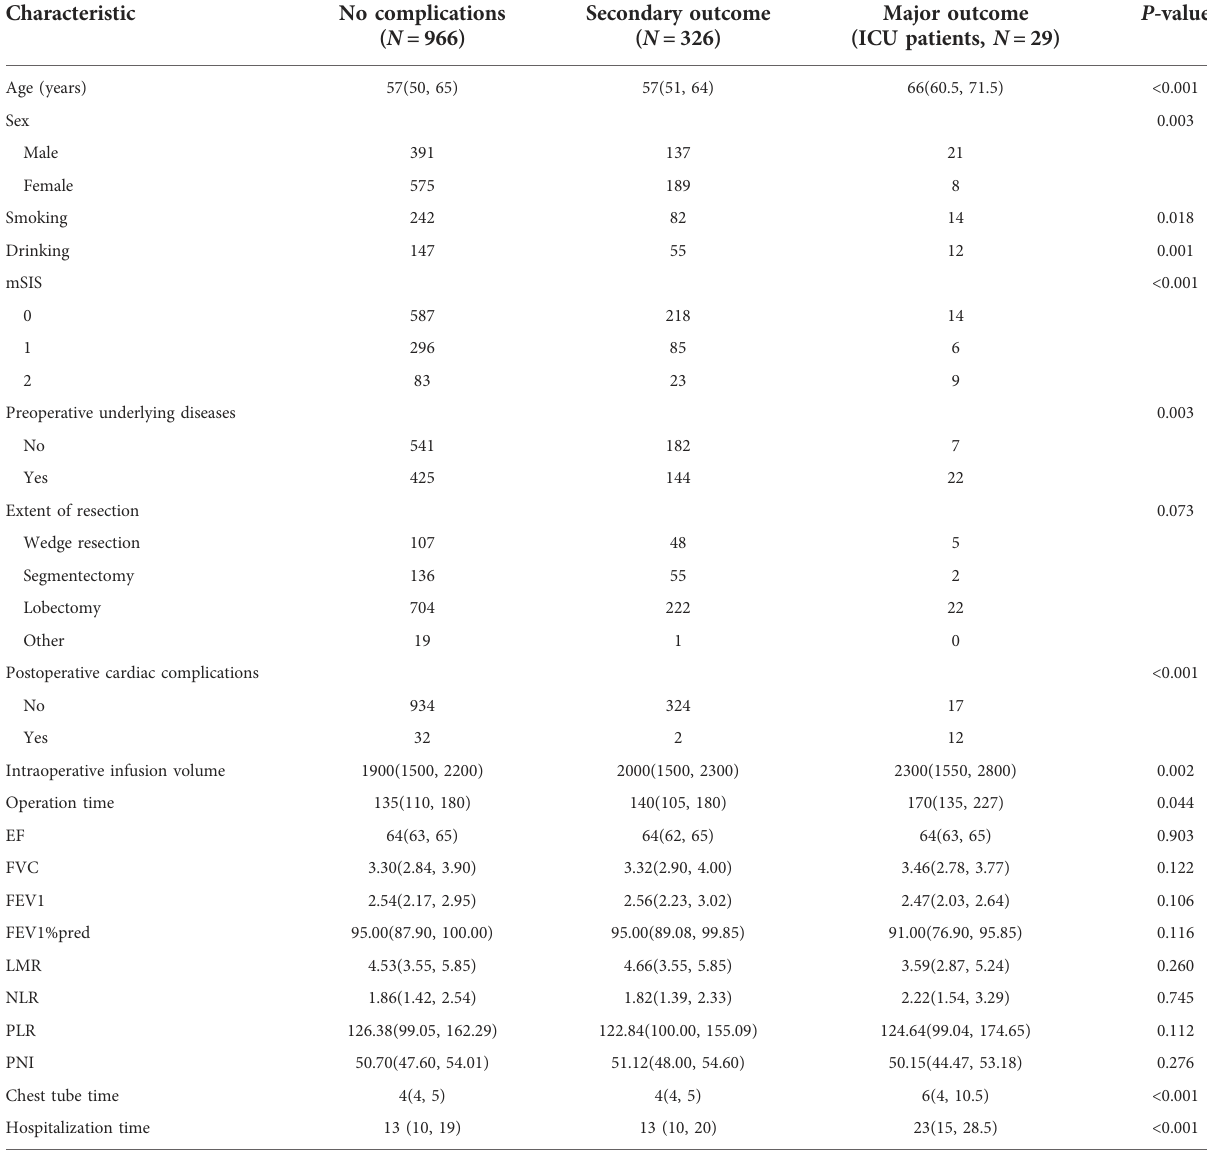
TABLE 1 Basic information of